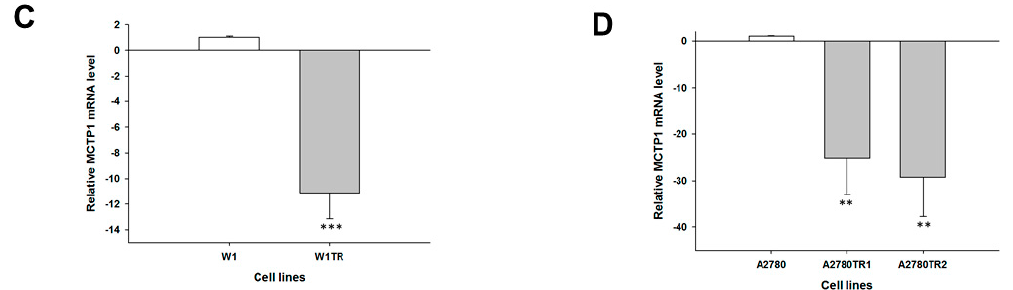
Figure 1. Expression analysis quantitative polymerase chain reaction (Q-PCR) of the MCTP1 gene in: W1 ( A ); and A2780 ( B ) CIS-resistant cell sublines. Expression analysis of the MCTP1 gene in: W1 ( C ); and A2780 ( D ) TOP-resistant sublines. The figure presents the relative gene expression in resistant cell lines (grey bars) with respect to the sensitive cell line (white bars), assigned as 1. The values were considered significant at ** p < 0.01 and *** p < 0.001.